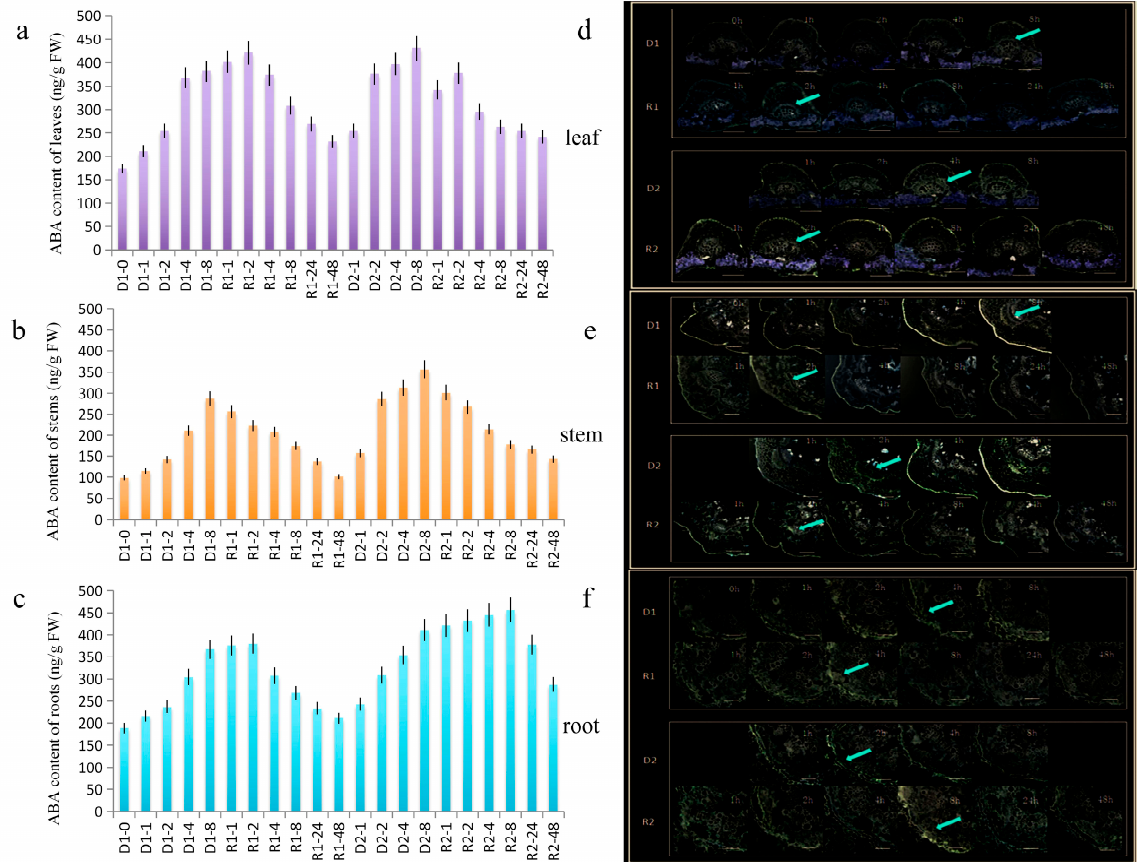
Figure 2. The abscisic acid (ABA) content and distribution analyses in peanut during drought stress memory process using HPLC and immunofluorescence localization assays. The time points of D1-1 to R2-48 were sampled to observe the expression and distribution-changing trends. The untreated group was used as the control (D1-0). ( a – c ) The ABA content of the leaves, stems, and roots in peanuts during the drought stress memory process. The mean and SD were obtained from more than three biological replicates. ( d – f ) The ABA immunostaining of leaves, stems, and roots following the same treatment regime described for a. The control samples were treated with PBS; green fluorescence (arrows) indicates the presence of ABA; and no color indicates a lack of staining. Bars = 50 μ m for leaf panels and 100 μ m for the stem and root panels.